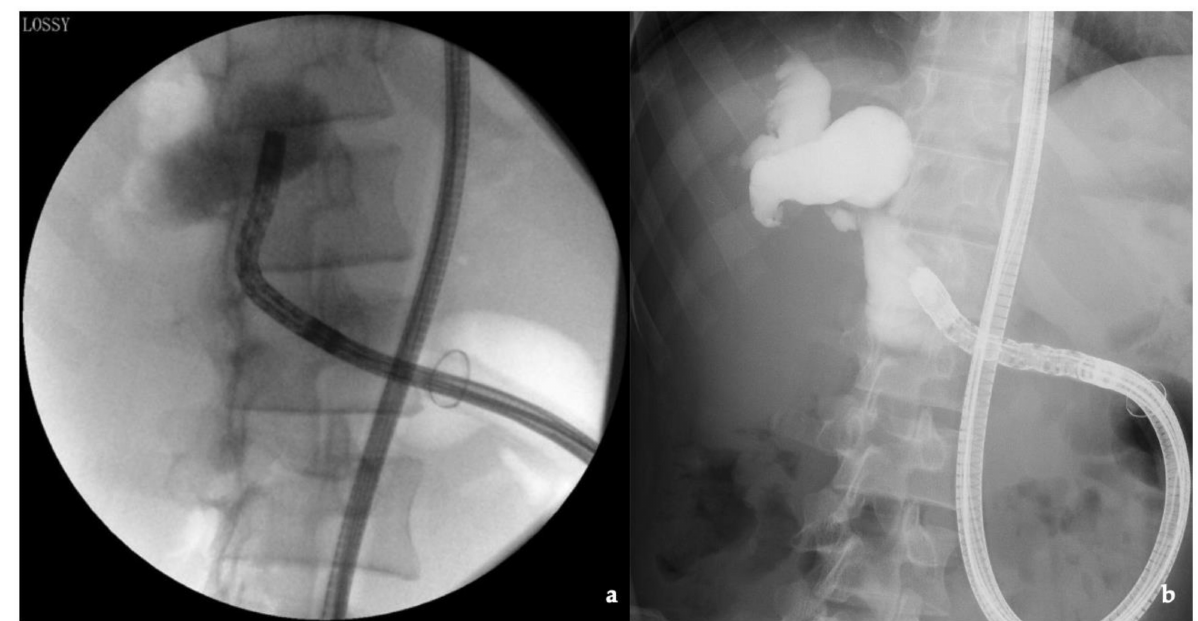
Figure 4. Reconstruction of the afferent limb to facilitate endoscopic insertion: ( a ) before reoperation, the insertion time required was approximately 70 min; ( b ) after reoperation, the insertion time was shortened to 22